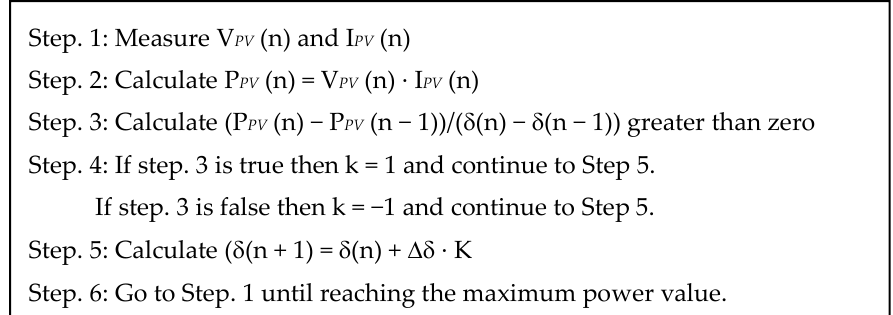
Figure 9. P&O technique algorithm.